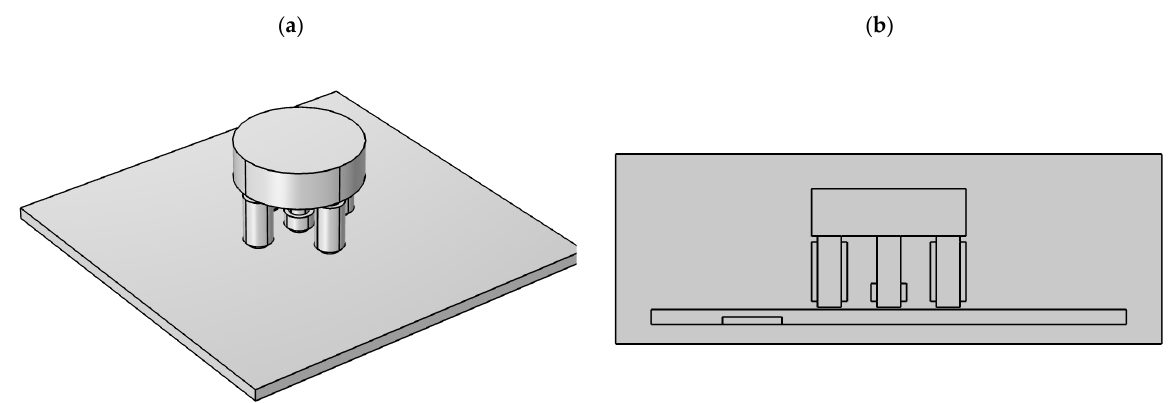
Figure 11. The geometry of the sensor and the specimen with flaw arrangements (the three-dimensional ( a ) and two- dimensional ( b ) configurations).